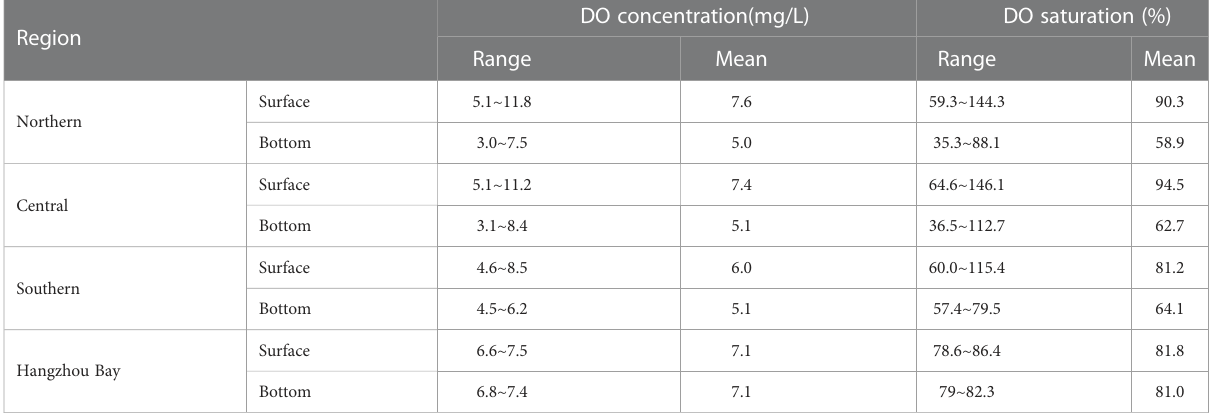
TABLE 1 Surface and bottom DO concentration and saturation in Zhejiang coastal area.